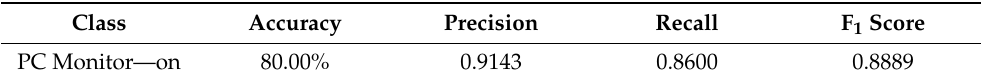
Figure 9. Confusion matrix results validating the performance of the ( a ) equipment and ( b ) occupancy activity model in terms of classification. Table 6. Equipment detection model performance based on the application of images from the testing dataset.